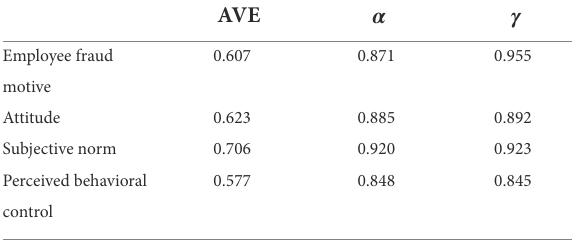
TABLE 7 The convergent validity and reliability of the